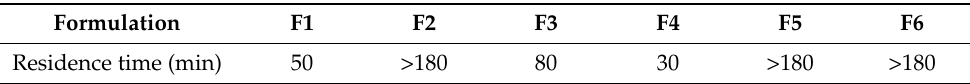
Table 3. Residence time (expressed in min) of tablets with Polygoni cuspidati extract (formulations F1–F6) to the porcine buccal mucosa ( n = 3;